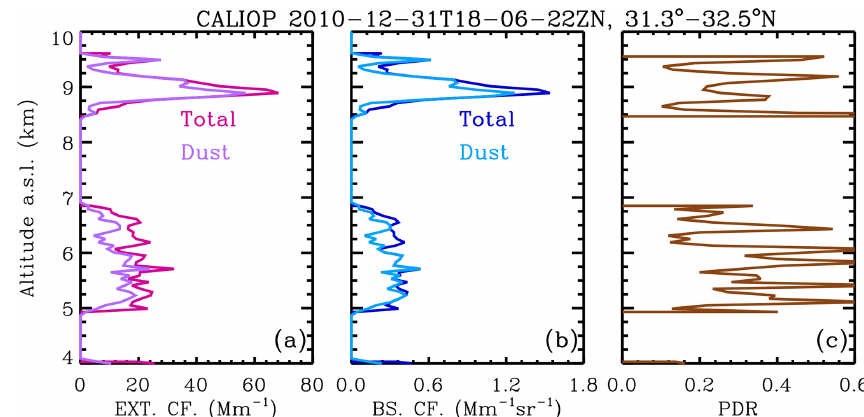
Figure 10. Profiles of the 532nm (a) dust and total (dust + non-dust) extinction coefficient, (b) dust and total (dust + non-dust) backscatter coefficient, and (c) particle depolarization ratio obtained/calculated from the CALIOP Level-2 aerosol profile product on 31 December 2010. The profiles within the latitude range of 31.3–32.5 ◦ N are integrated here.